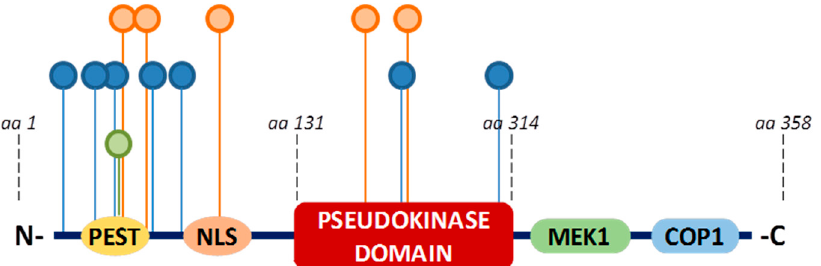
Figure 5. TRIB3 post-translational modifications. Phosphorylation (blue circle), ubiquitylation (orange circle), and methylation (green circle) sites reported from www.phosphosite.org accessed